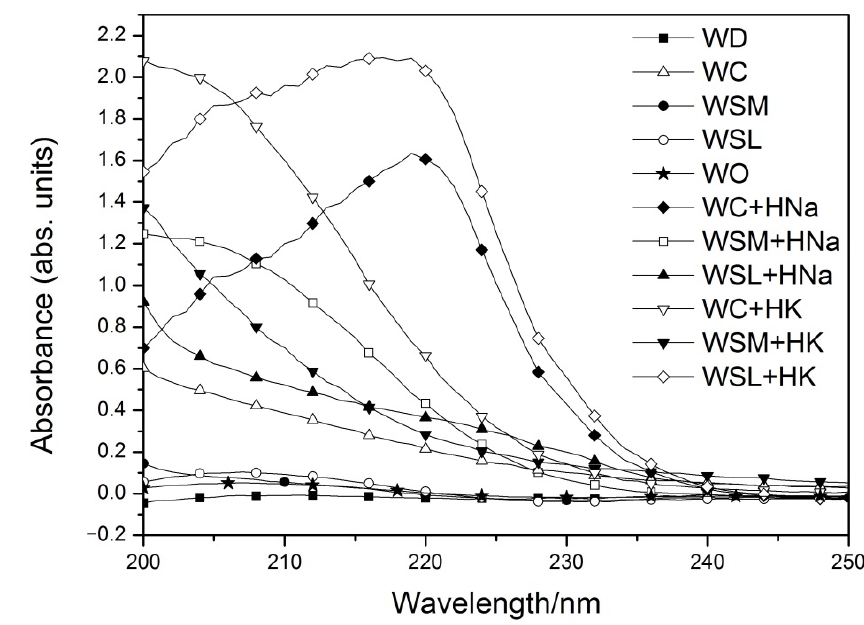
Figure 10. UV-vis spectra of pure waters and wastewaters.